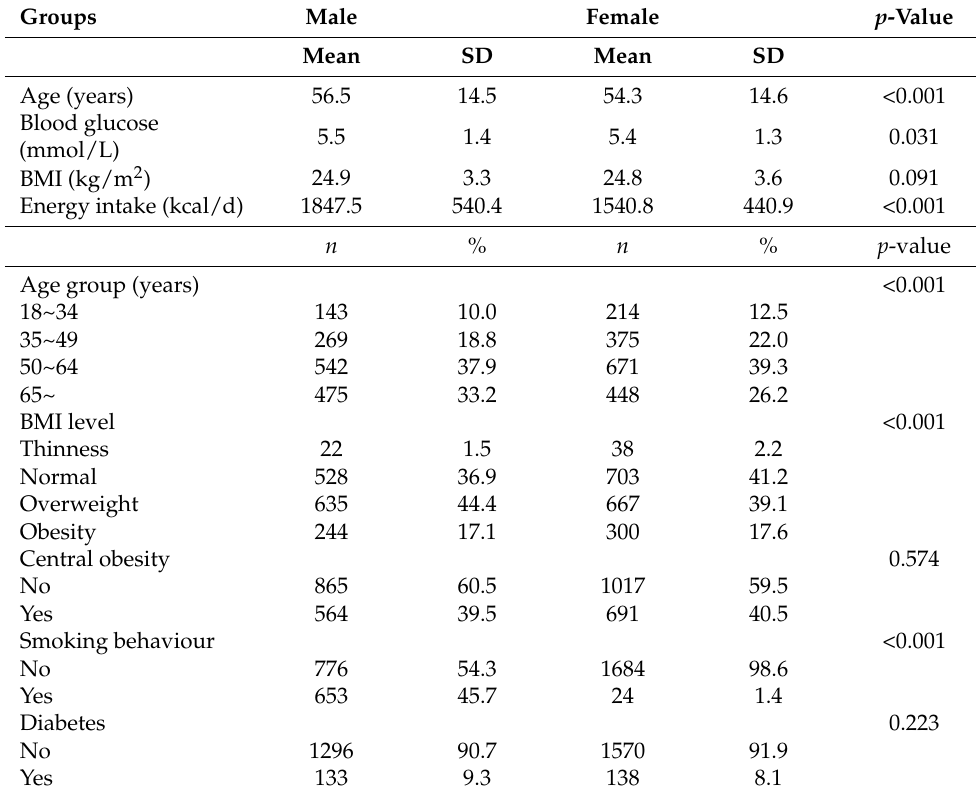
Table 1. Characteristics of the basic information distribution by gender.